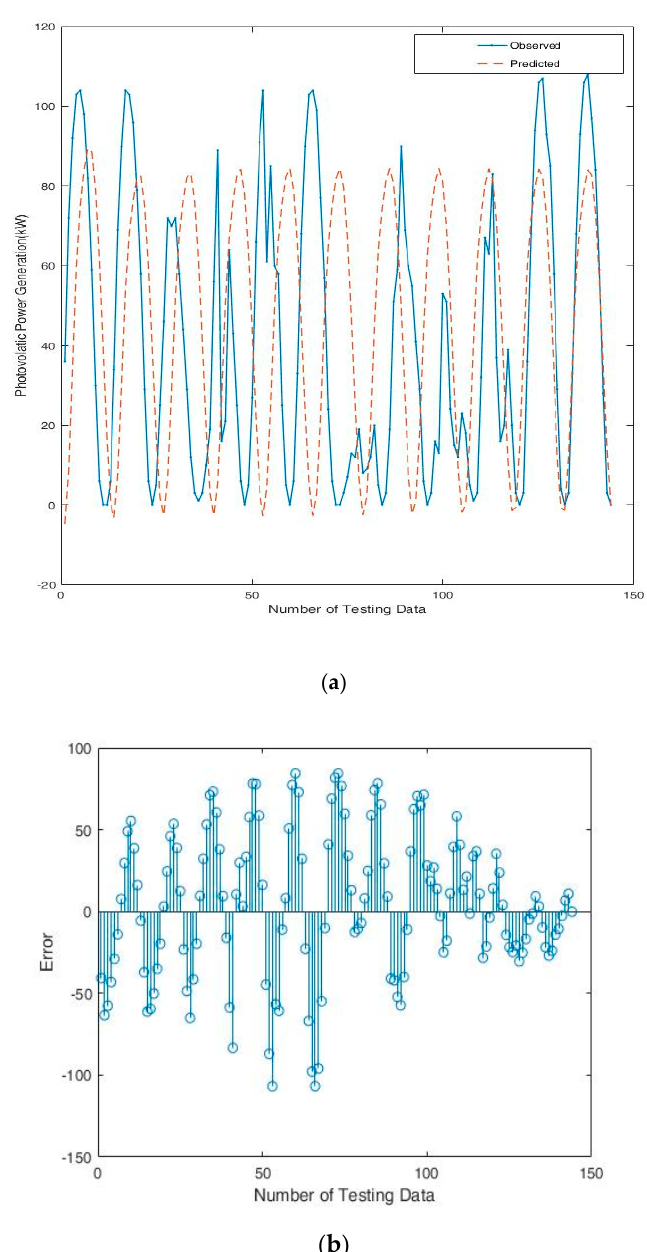
Figure 4. Wind power prediction of existing long short-term memory (LSTM): ( a ) Comparison of observed values with predicted values using LSTM; ( b ) Predicted error for observed values and predicted values.